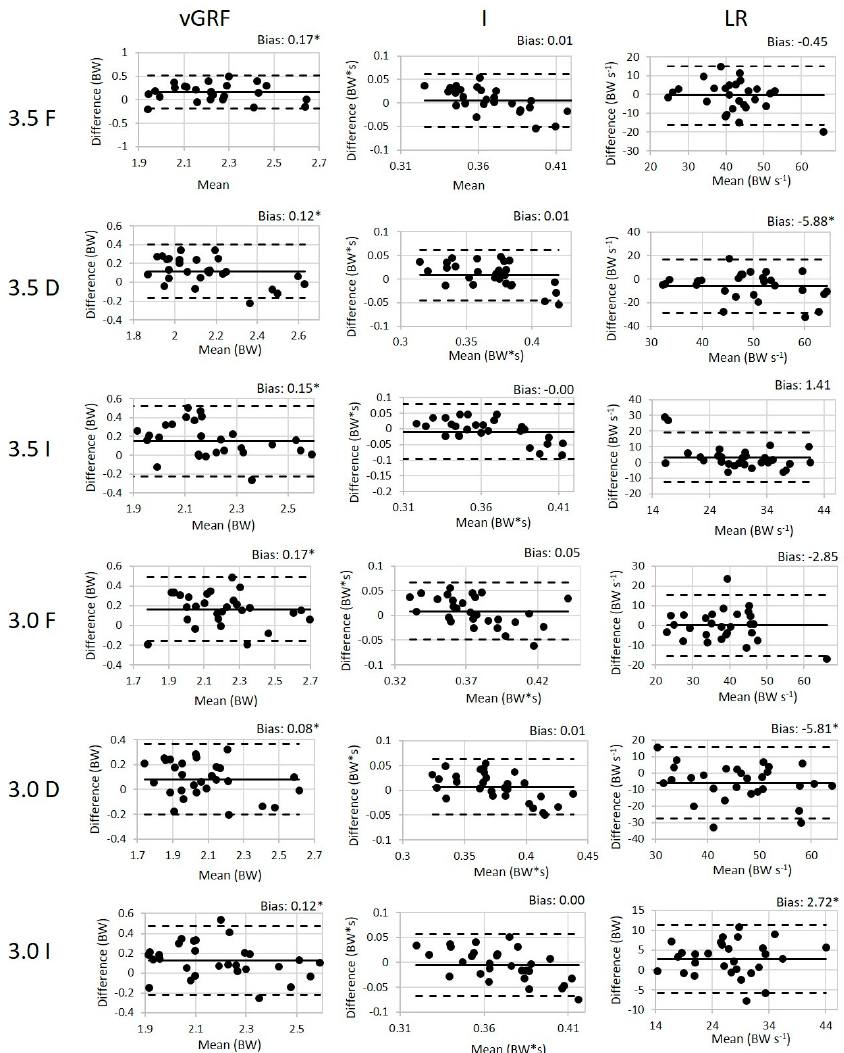
Figure 3. The Bland–Altman plots for peak force, impulse, and loading rate with the 100 Hz loadsol ® for both running speeds (3.0 and 3.5 m/s) flat (F), inclined (I), and declined (D). The difference is calculated by subtracting the loadsol ® values from the force plate values. The bias (mean difference) is displayed for each variable with a * indicating a statistically significant difference between the force plate and loadsol ® .